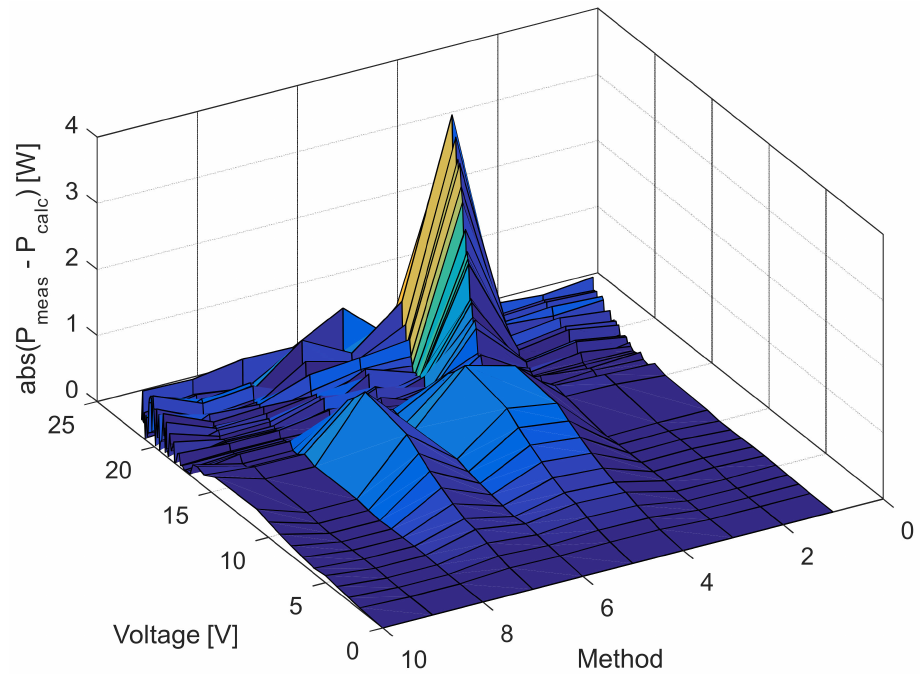
Figure 19. Difference between the measured and calculated power values for the methods listed in Table 5.